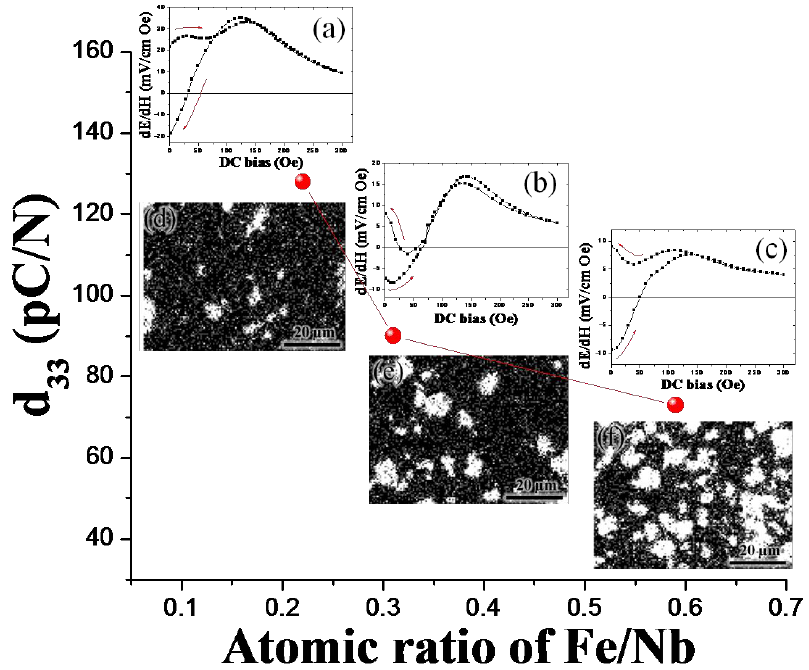
Figure 23. Longitudinal piezoelectric strain coefficient for (1 − x) KNNLS–x NZF composites as a function of atomic ratio of Fe/Nb. ME coefficient for (1 − x)KNNLS-xNZF / Ni / (1 − x)KNNLS-xNZF bending mode laminates: (a) x = 0.1; (b) x = 0.2; and (c) x = 0.3. Fe (white color) mapping images for (1 − x)KNNLS-xNZF composites: (d) x = 0.1; (e) x = 0.2; and (f) x =